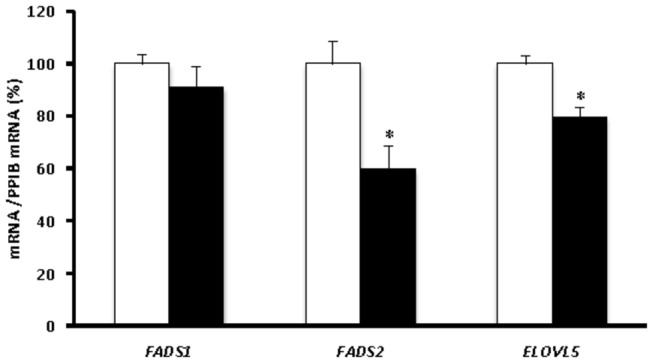
Fatty acid desaturase and elongase mRNA-expression (mRNA/PPIB mRNA) in peripheral blood.Expression levels were normalized using the expression of PPIB as the endogenous housekeeping gene. Black bars correspond to the AE children (n=20), and white bars correspond to the non-AE children (n=104). FADS1 encodes Δ5-desaturase (-9.40%, D5D), FADS2 Δ6-desaturase (-40.30%, D6D) and ELOVL5 elongase-5 (-20.36%). Each bar represents the mean ± S.E.M. of the percentage of gene expression in AE children compared to the reference group, which showed 100% expression. *p<0.05.